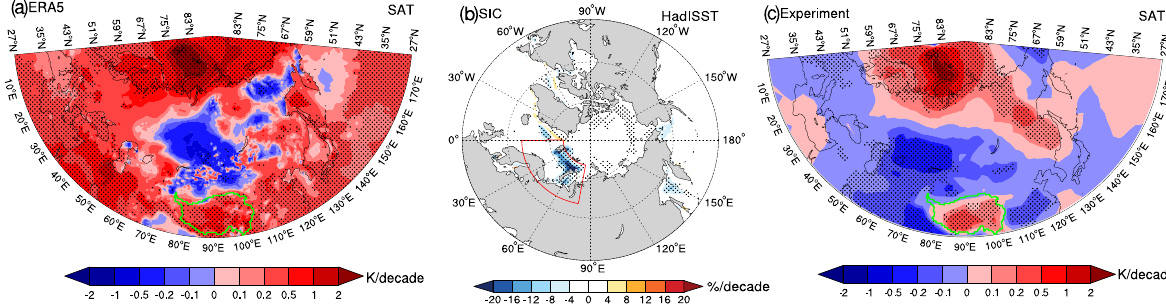
Fig. 1 Linear trends of the winter SAT and SIC during 1979 – 2018. a Linear trend in the winter SAT derived from ERA5 reanalysis (K/decade); b Linear trend in the winter SIC derived from HadISST dataset (%/decade); c The same as in a , but for BKS experiment results (K/decade). Stippled areas indicate regions exceeding the 90% statistical con fi dence level. The areas of the Tibetan Plateau (TP) with altitude above 2500 m are shown by green lines in a and the region of BKS (65° – 80°N, 0° – 80°E) is outlined by red lines in b